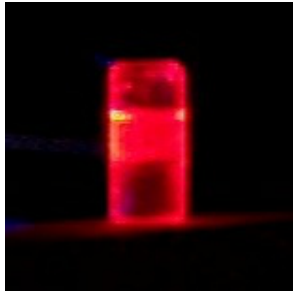
FIGURE 6 . Luminescence photo showing phosphate binding to Eu-TTFA complex. See